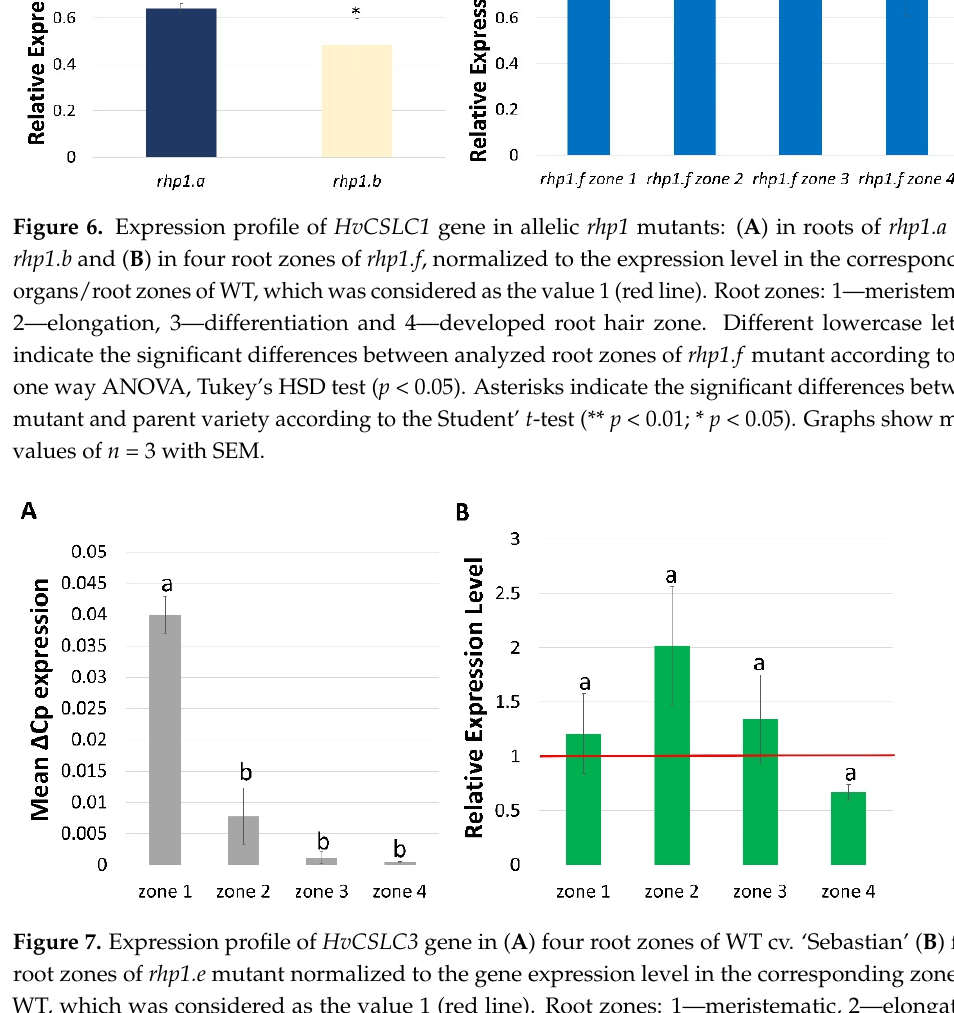
Figure 6. Expression profile of HvCSLC1 gene in allelic rhp1 mutants: ( A ) in roots of rhp1.a and rhp1.b and ( B ) in four root zones of rhp1.f , normalized to the expression level in the corresponding or- gans/root zones of WT, which was considered as the value 1 (red line). Root zones: 1—meristematic, 2—elongation, 3—differentiation and 4—developed root hair zone. Different lowercase letters indi- cate the significant differences between analyzed root zones of rhp1.f mutant according to the one way ANOVA, Tukey’s HSD test ( p < 0.05). Asterisks indicate the significant differences between mutant and parent variety according to the Student’ t -test (** p < 0.01; * p < 0.05). Graphs show mean values of n = 3 with SEM.